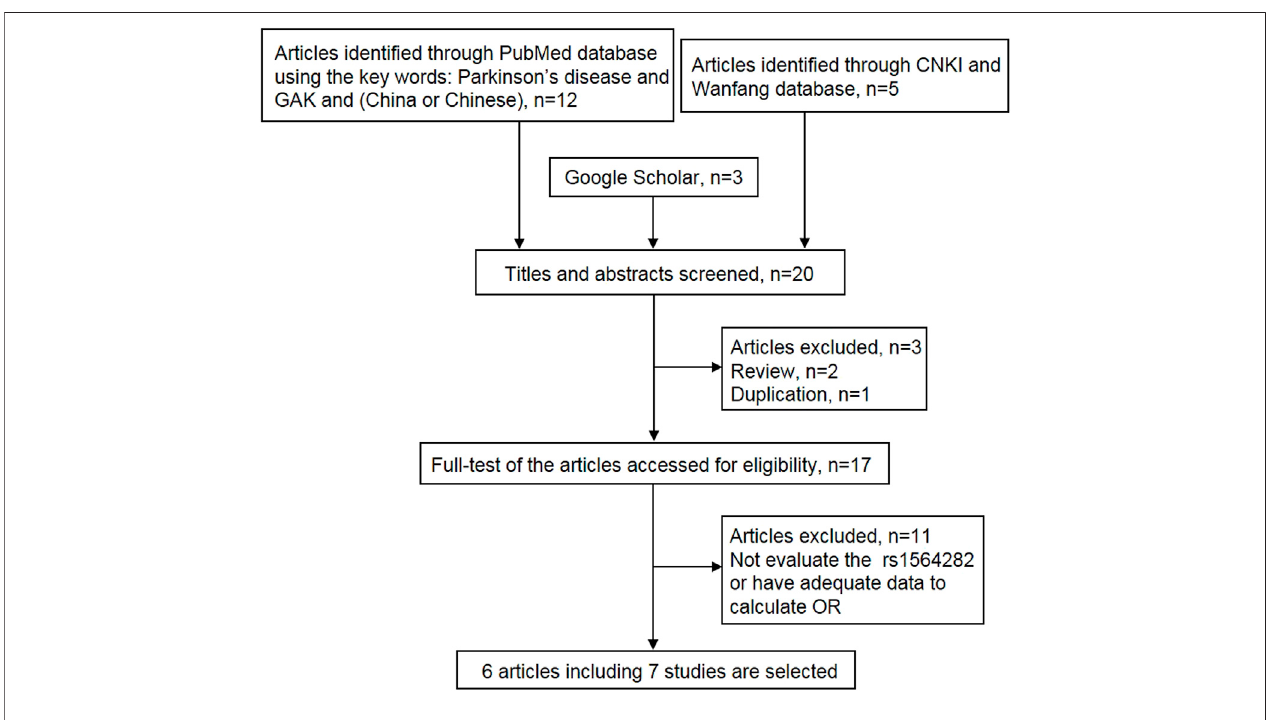
FIGURE 1 | Flow chart of the literature search process.